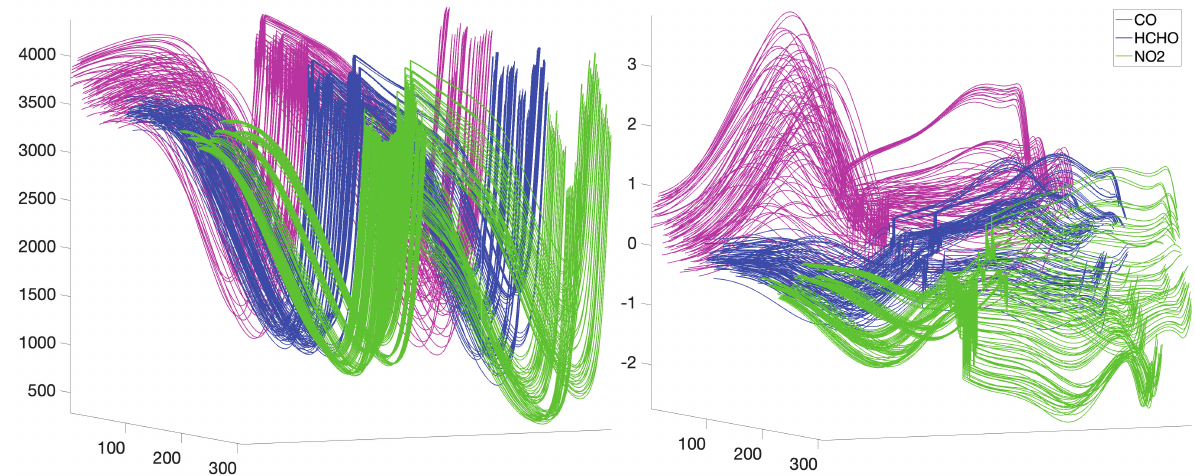
Figure 9. Unfolded data in dataset #3. Initial values ( left ) and MCUGS signal ( right ). All experiments are shown superposed (5000 values per 2 sensor signals for 309